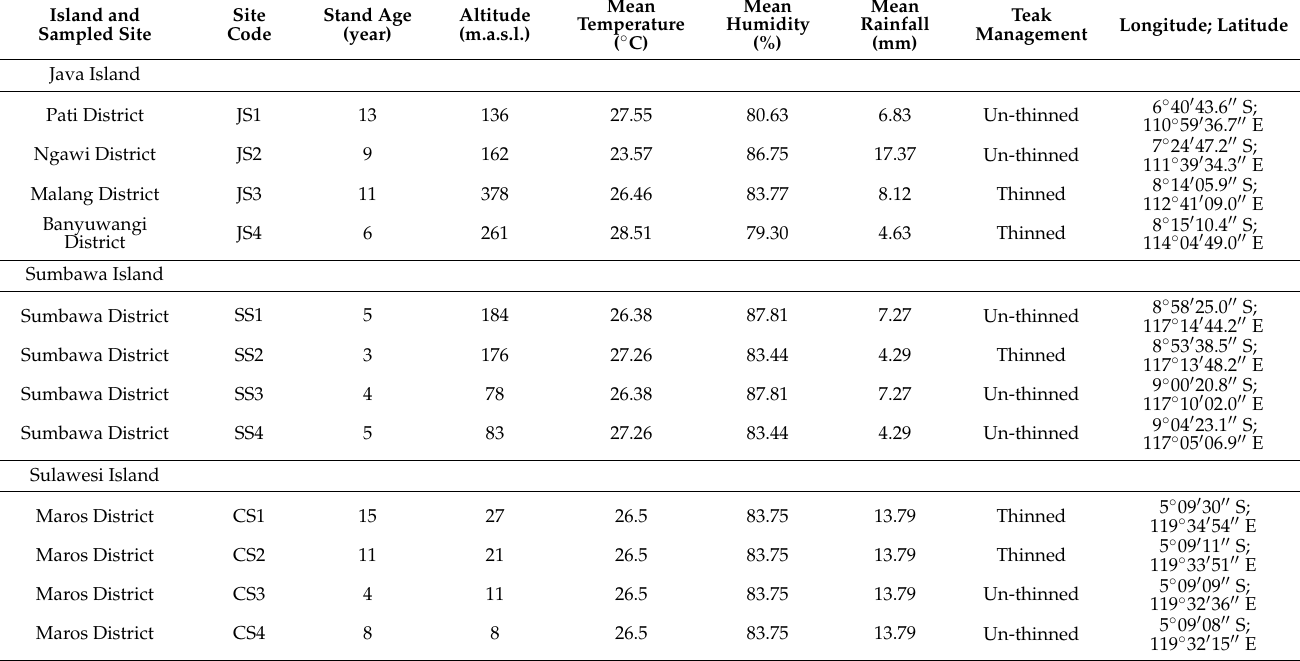
Table 1. Habitat variable data on each site of teak plantation in Java, Sumbawa, and Sulawesi islands. Island and Sampled